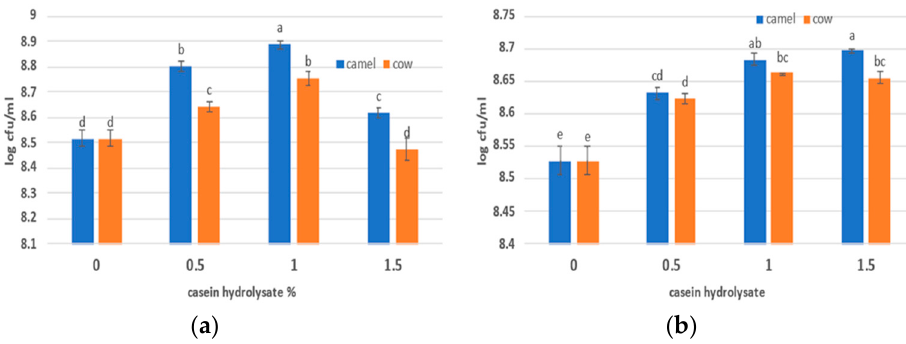
Figure 5. Viability of total bacterial count of yoghurt made from cow milk with different levels of camel and cow casein hydrolysate after storage for one day at 4 °C ( a ) and after three weeks ( b ). No significant differences with the same letters among treatments.